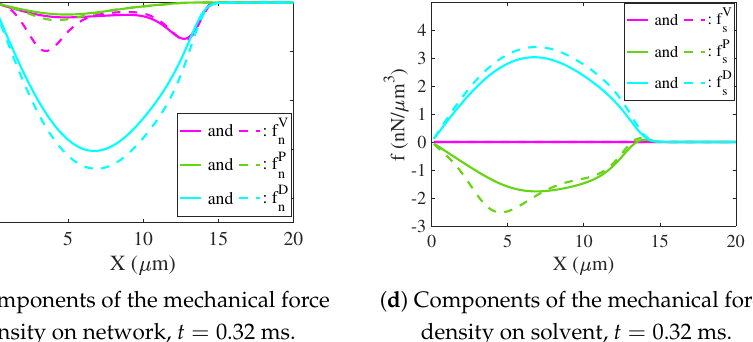
Figure 7. Components of the network and solvent mechanical force densities along the positive = 0.001 M (solid) and C ∗ = 0.05 M (dashed) at ( a , b ) t = 0.16 ms and ( c , d ) t = 0.32 ms. x -axis for C ∗ Na Na Here f V , f P , and f D represent the densities of viscous force, pressure force, and drag force on phase i i i i ( i = s , n ),